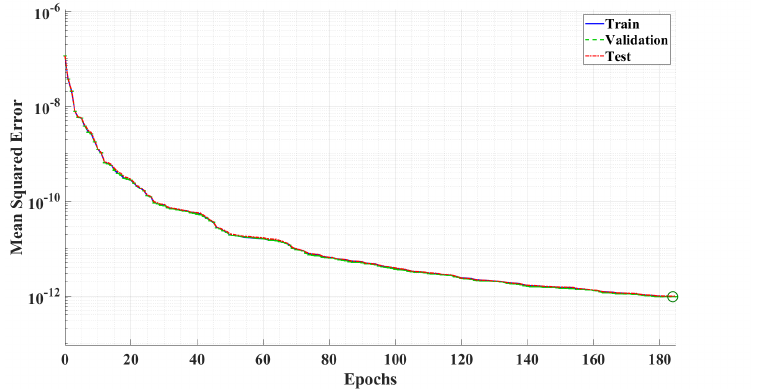
Figure 4. MSE Performance of proposed DNN Beamformer over the training, test and the validation dataset. The best MSE performance obtained at 184 epochs is indicated with a